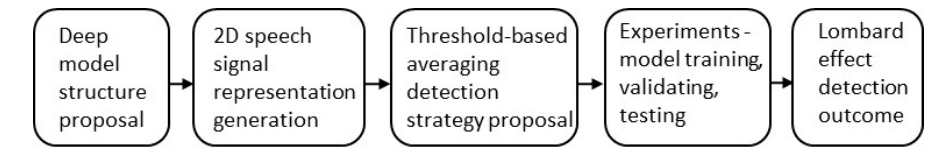
Figure 1. Flowchart of the Lombard speech detection process.